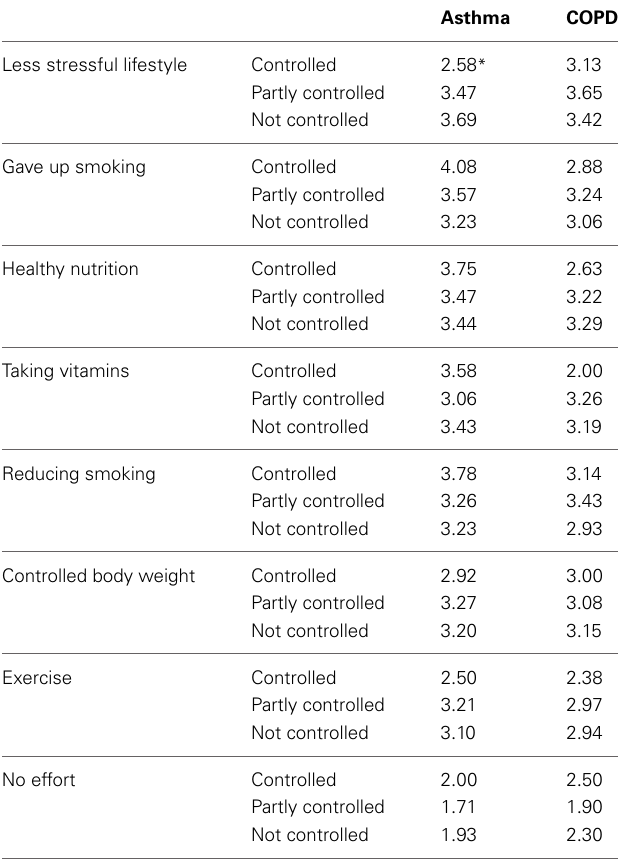
Table 7 | Efforts to maintain health according to the perceived condition of asthma or COPD of